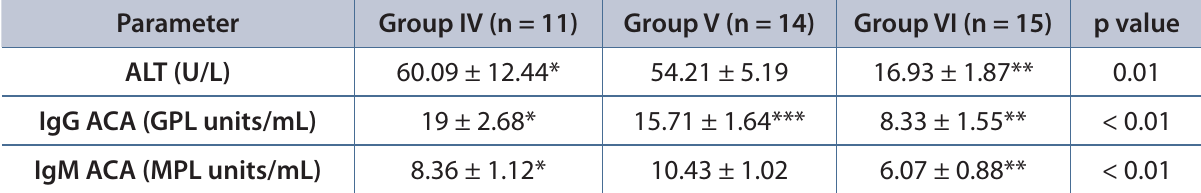
Table 5. Laboratory data of hemodialysis patients Parameter